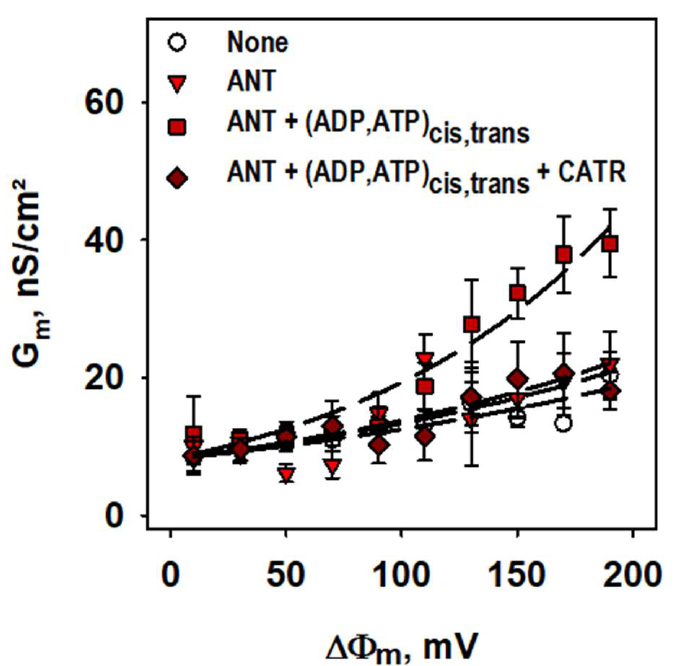
Figure 1. ANT1 does not contribute to the basal proton leak. Total membrane conductance (G m ) was measured at different membrane potentials ( ∆Φ ) and membrane compositions (s. legend). Planar bilayer membranes were made of 45:45:10 mol % PC:PE:CL. Lipid concentration was 1.5 mg/(mL of buffer solution). Protein concentration measured by BCA assay was 4 µg/(mg of lipid). Buffer contained 50 mM Na 2 SO 4 , 10 mM Tris, 10 mM MES and 0.6 mM EGTA at pH = 7.34 and T = 306 K. ADP, ATP and CATR were added at concentrations 2 mM, 2 mM and 100 µM. Lines represent the least square regression fit of an exponential function to the data. Data are the mean ± SD of at least three independent experiments.